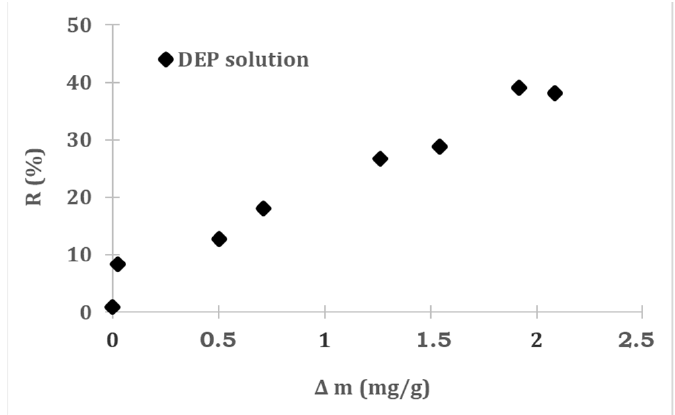
Figure 5. Dependence of the rejection coefficient on the amount of grafted layer.